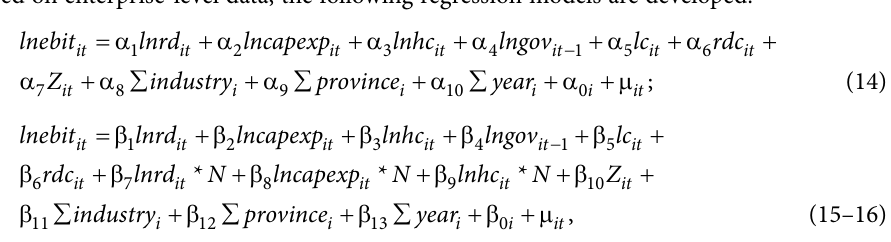
Figure 1. Theoretical